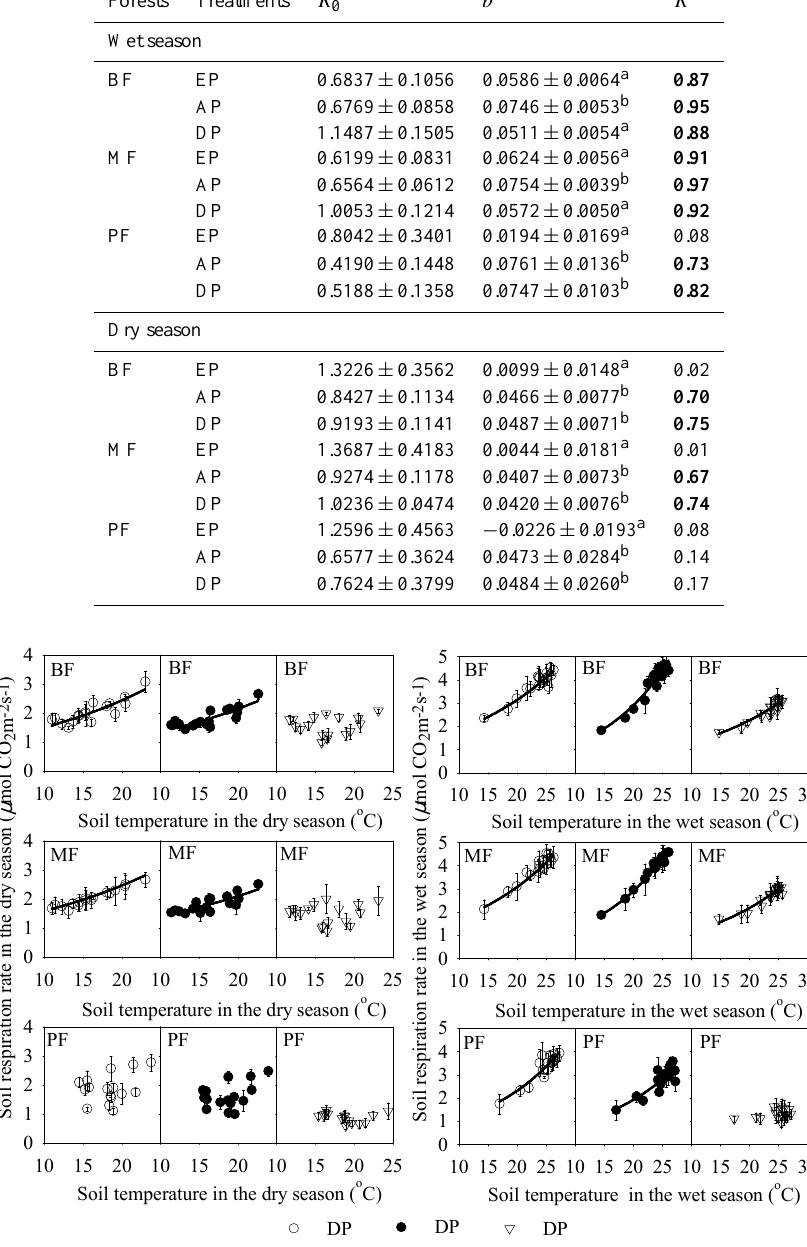
Fig. A1. Relationships of soil respiration rate ( R , µmolCO 2 m − 2 s − 1 ) and soil temperature at 5cm depth ( T , ◦ C) (exponential equation: R = Fig A1. 16 R 0 exp (bT ) ) under different seasons and different precipitation treatments at the DNR forests. The treatments are as follows: precipitation exclusion (EP), ambient precipitation (AP), and double precipitation (DP). The forests are as follows: broadleaf forest (BF), mixed forest (MF), and pine forest (PF). The equations are listed in Table